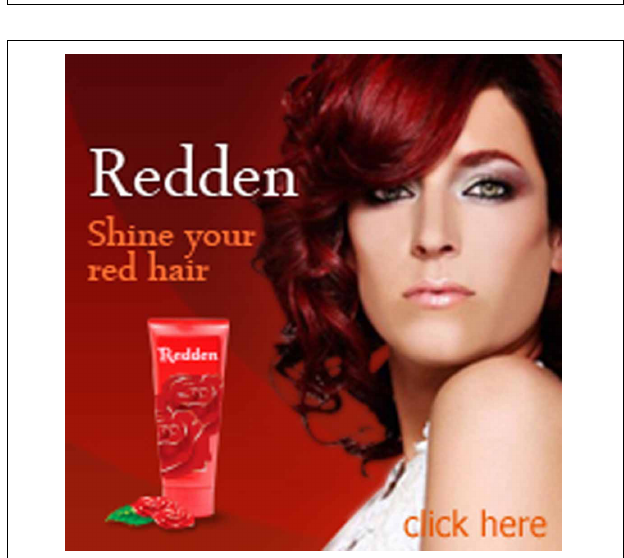
FIGURE 5 | Fabricated vertical banner advertisement for “Redden” in the averted gaze